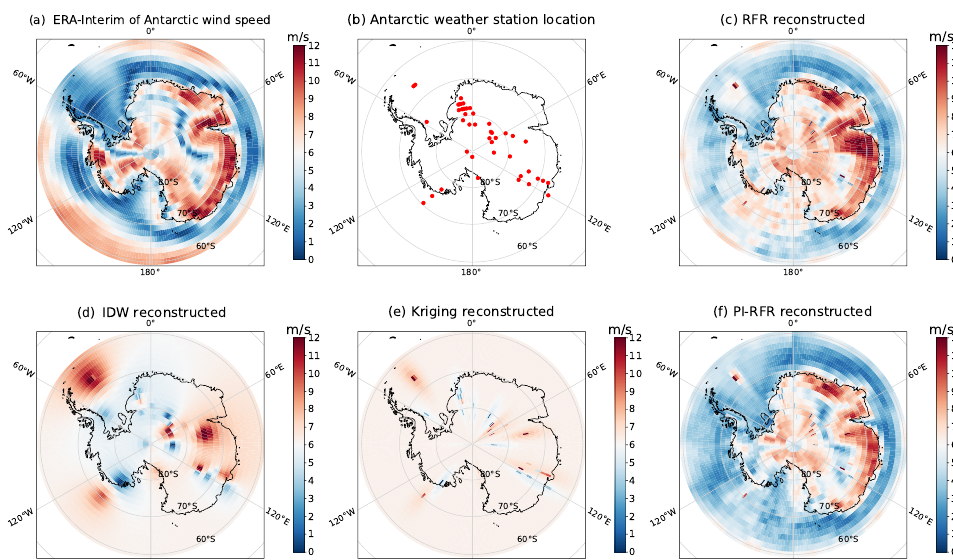
Figure 13. Reconstruction results of Antarctic station wind speed data by IDW, Kriging, RFR and PI-RFR methods. The subfigure ( a ) is the data of the reanalysis data, and we take it as the ground truth. The subfigure ( b ) represents the location of the Antarctic weather station. The subfigures ( c – f ) show the reconstruction results of RFR, IDW, Kriging and PI-RFR, respectively.